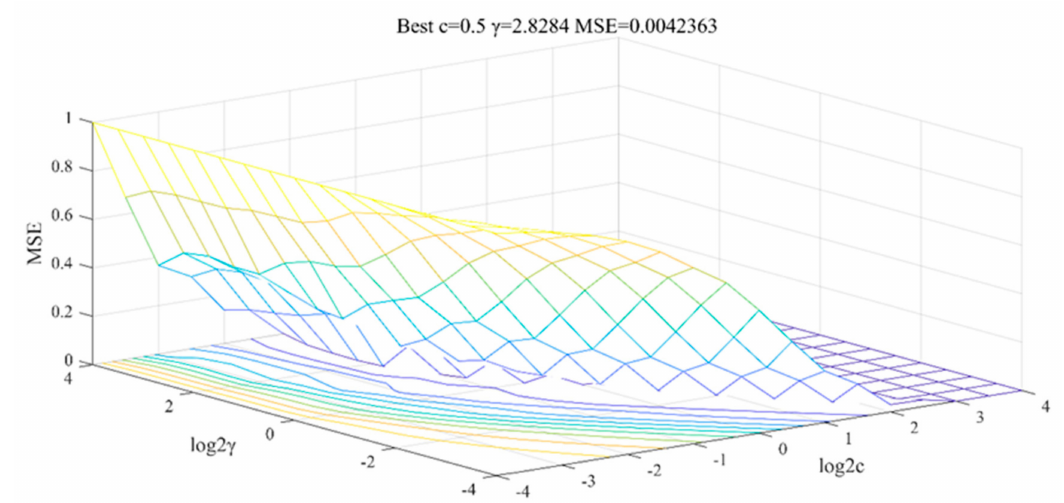
Figure 5. A 3D contour map for parameter determination of single-factor SVRM model using the grid-search method.